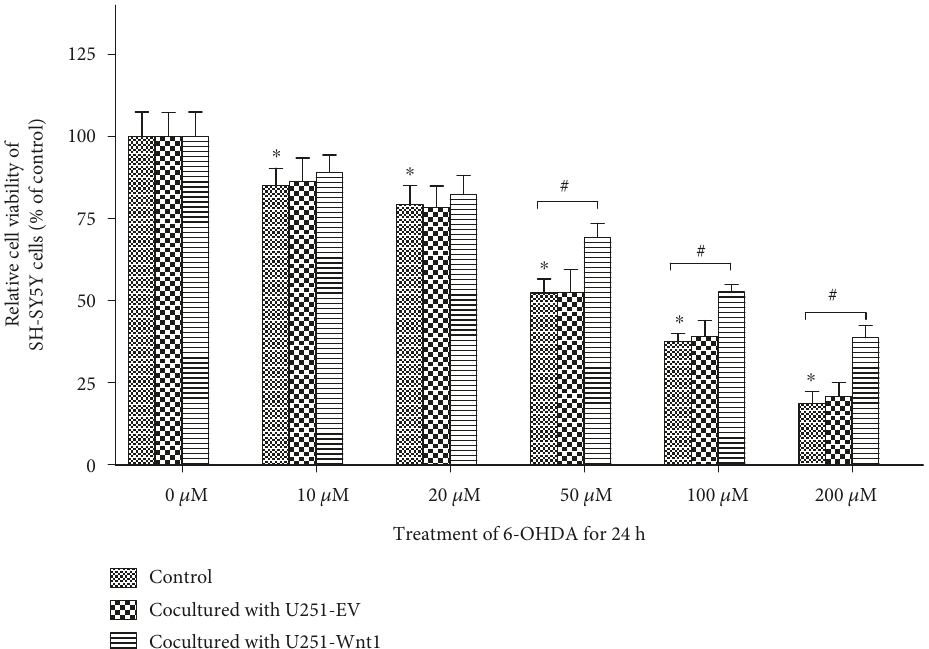
Figure 4: Coculturing with U251-Wnt1 cells attenuated 6-OHDA-induced injury in SH-SY5Y cells. SH-SY5Y cells were indirectly cocultured with U251-Wnt1 cells or U251-EV cells, with SH-SY5Y cells cultured alone as the control, and then treated with 50 μ M 6-OHDA for 24h; cell viability was assessed using the MTT assay. The data are expressed as percentages relative to the control group with 0 μ M 6-OHDA and are presented as the mean ± SD from four independent experiments. ∗ P < 0 05 compared to the control with 0 μ M 6-OHDA; # P < 0 05 compared to the control group at the corresponding 6-OHDA